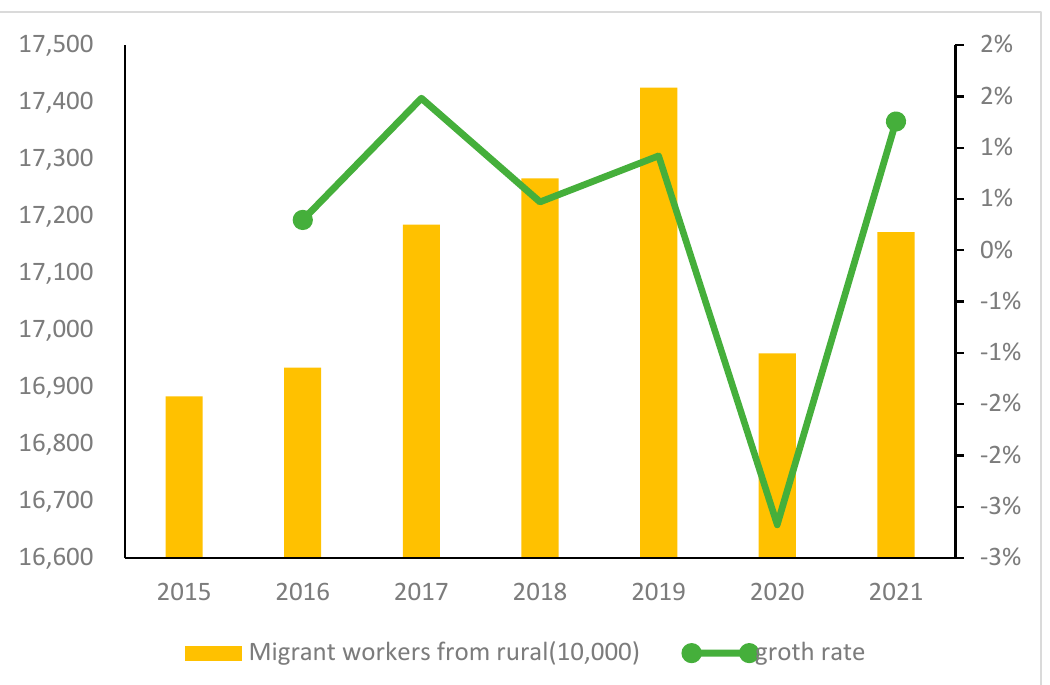
Figure 3. Number of migrant workers in China from 2015 to 2021. (Data from the China National Bureau of Statistics 2015-2021 Monitoring Survey of Migrant Workers).